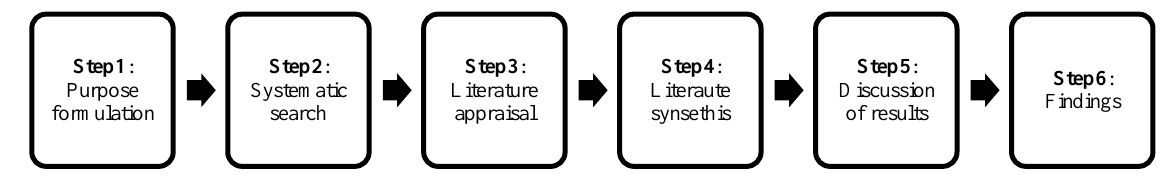
Figure 1: Stepwise Integrative Review